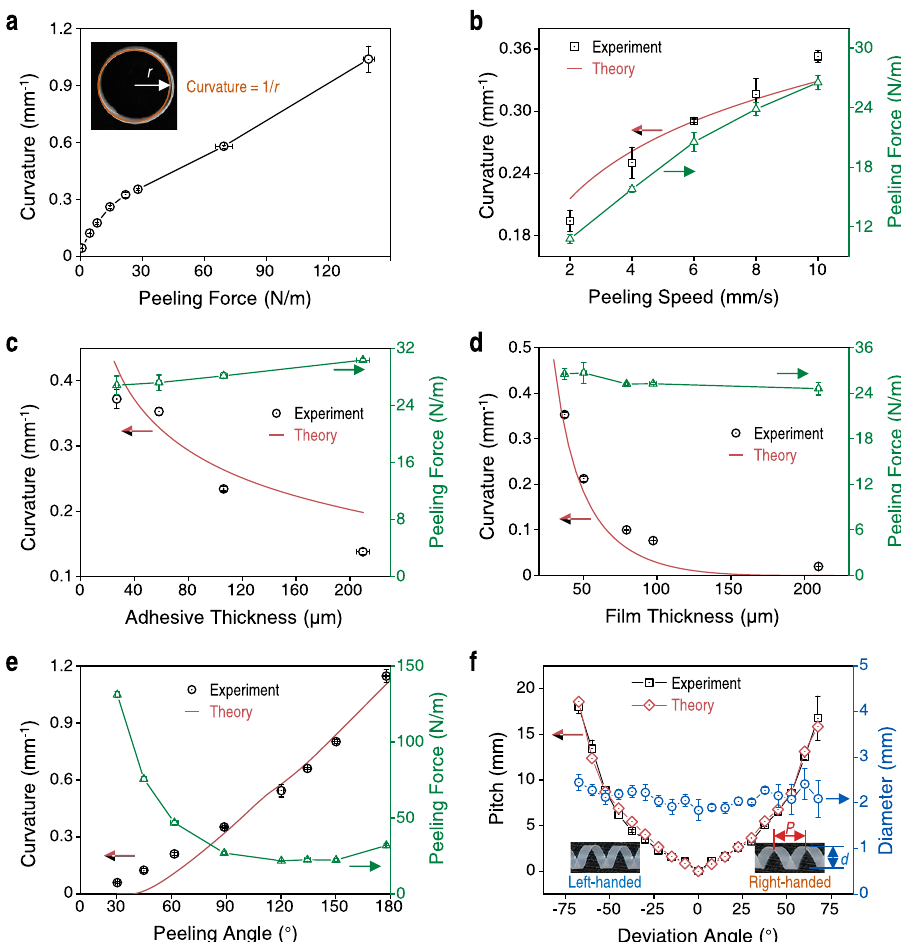
Fig. 2 | Effect oftheadhesivelayerand peeling parametersonshapemorphing of plastic fi lms. a Films peeled with higher peeling forces exhibited larger curva- tures.Inset:opticalphotographofapeeledPTFE fi lm(37 μ mthick,peelingangleof 90°andpeelingspeedof10mm/s).Curvatureisde fi nedas1/ r ,where r istheradius of the circle. b Graph showing fi lms that were peeled faster (measured as speed in mm/s)requiredlargerpeelingforces(greencurve)and theyresultedinmorecurly fi lms (black dots and red curve). The theoretical results are quantitatively con- sistent with the experimental ones. c Graph of curvature and peeling force versus thickness of the adhesive layer (30 – 200 μ m examined) showing fi lms on thicker adhesives required slightly higher peeling forces to detach but they formed less curly shapes (lower curvature). d Graph showing plastic fi lm thickness did not